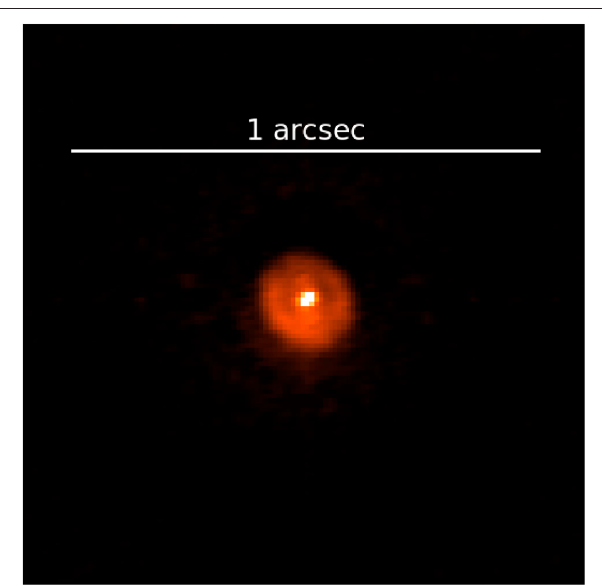
FIGURE 9 | Nova V906 Car observed with Zorro on November 22, 2020;978 daysafteritsexplosion.Theimagewastakenwiththe832 nm fi lter andshowsanexpandingnovashellwitharadiusof90 mas.Detectionofnova shells close to their progenitors will allows better understanding of their early geometries and expansion rates to a degree unachievable by seeing- limited observations.